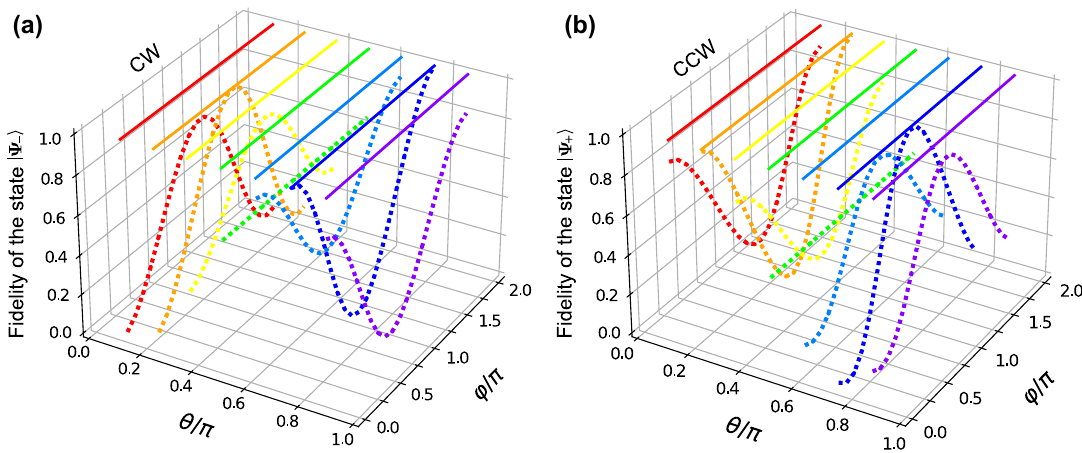
Figure 4: The fidelity of different topological operations in (a) CCW and (b) CW with different initial states. Here, solid lines represent topological amplification of the nontrival topological operations with an EP in (a) CCW ( 𝜈 = 0 . 5) and (b) CW ( 𝜈 = − 0 . 5), while the dotted curves illustrate the trival topological operations without and EP in CCW and CW ( 𝜈 = 0). Parameters in the simulations are 𝜔 ∕ 2 𝜋 = 51 . 8 MHz, 𝛾 ∕ 2 𝜋 = 41 kHz, m = 20 ng, Δ = − 𝜔 = 𝜅 = 𝜅 , 𝜆 = 390 nm, 𝜒 ∕ 2 𝜋 = 12 × 10 18 ℏ , , g ∕ 2 𝜋 = 5 MHz, 𝜅 ∕ 2 𝜋 = 5 MHz, 𝜅 c c a m m m and the topological operation times are T = 10 μ s for (a and b) and T = 4 . 1 μ s for (c and d). Other parameters take the same values as in Figure